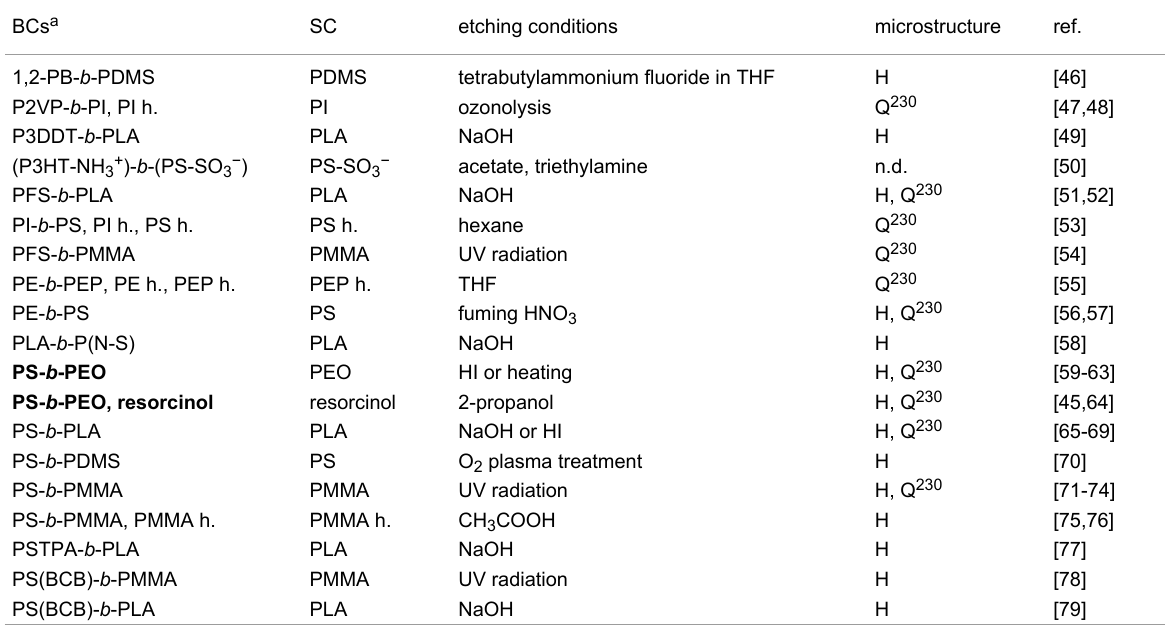
Table 1: Block copolymers (BCs), sacrificial components (SC), and the microstructures of the porous polymeric architectures. BCs